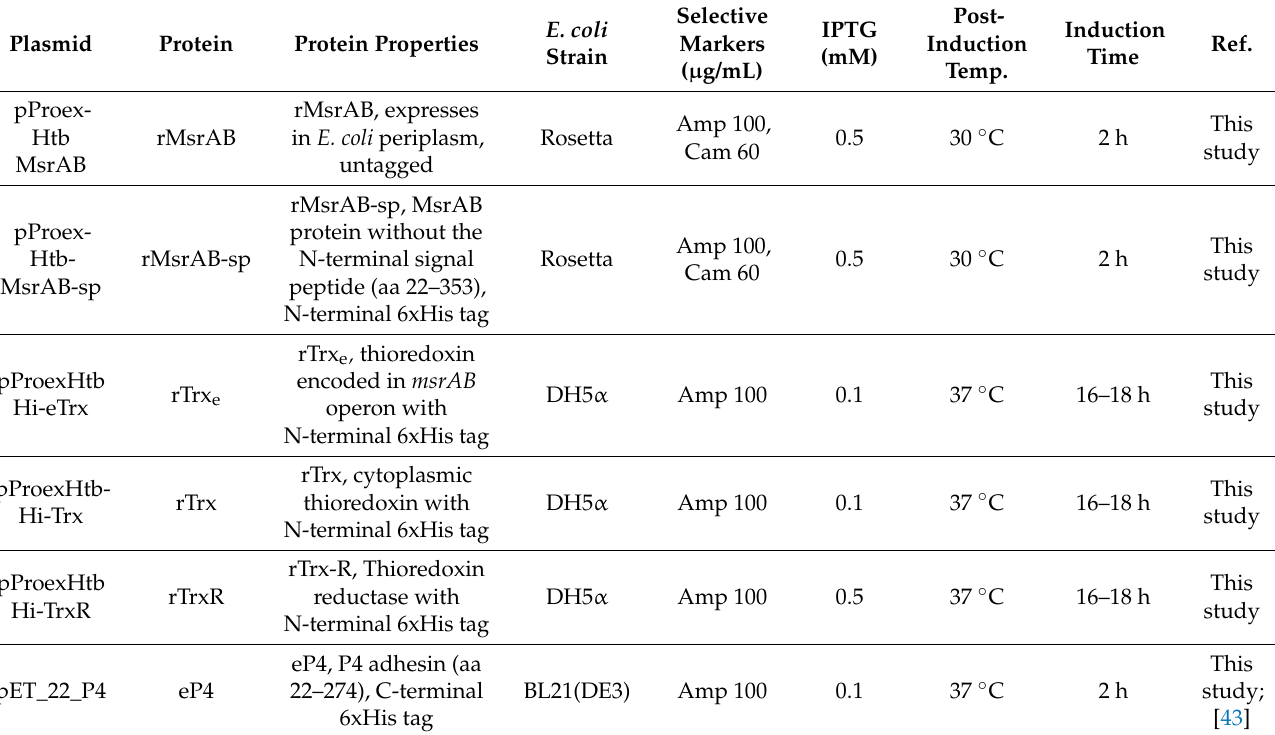
Table 2. Optimised protein expression conditions for recombinant proteins used in this